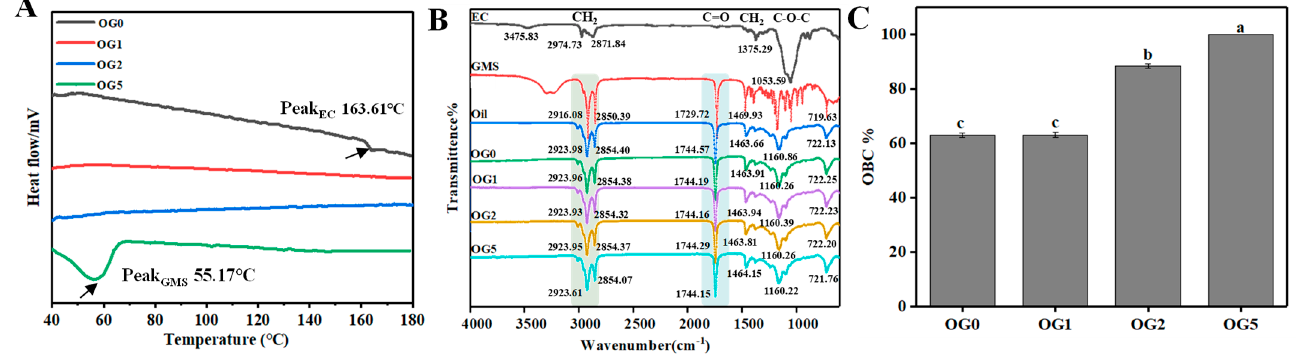
Figure 2. DSC ( A ), FTIR ( B ) and oil binding capacity ( C ) of EC oleogels with different content of GMS. Different lowercase letters represent significant differences ( p < 0.05) .